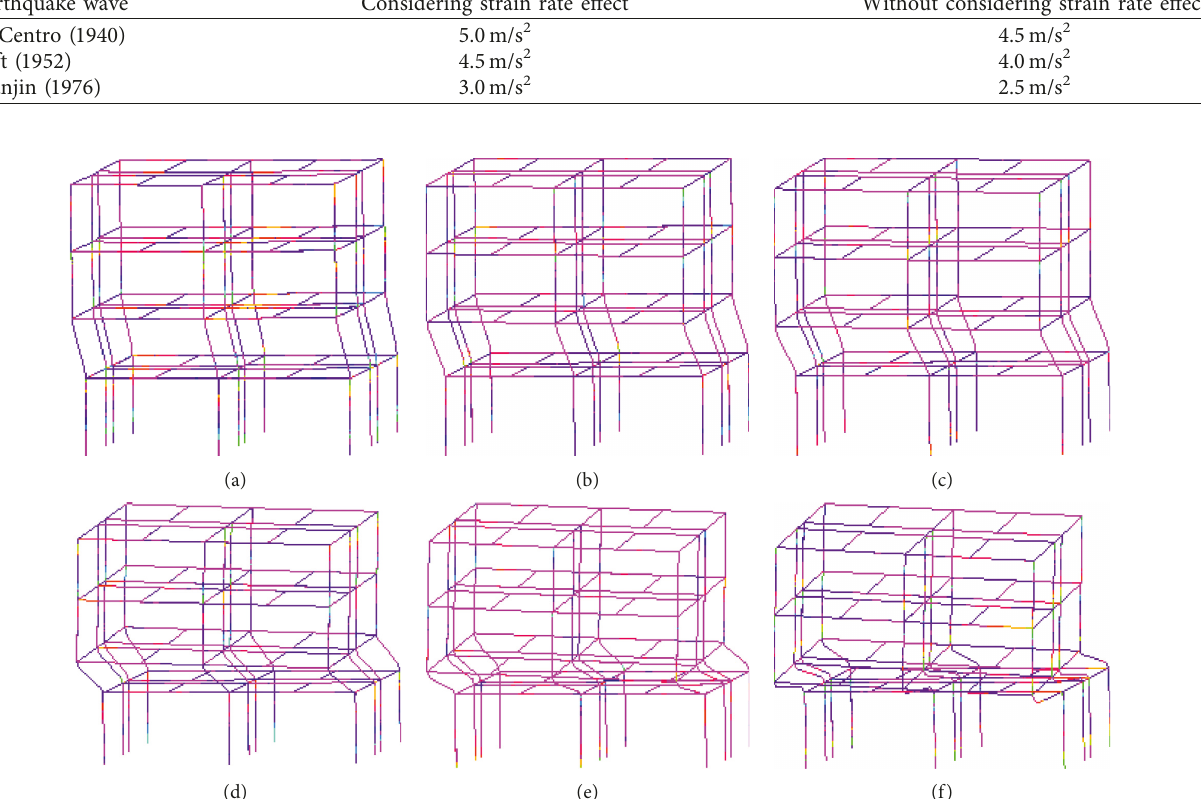
Figure 9: Collapse process of the structure subjected to three-component excitation under El Centro wave. (a) t � 9.50s. (b) t � 9.70s.